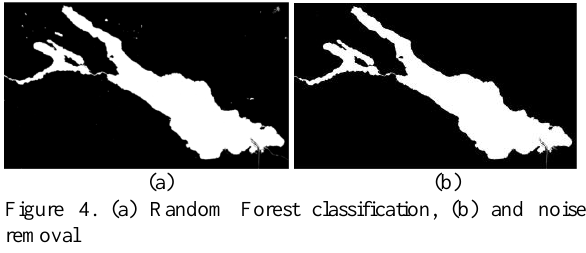
Figure 4. (a) Random Forest classification, (b) and noise removal